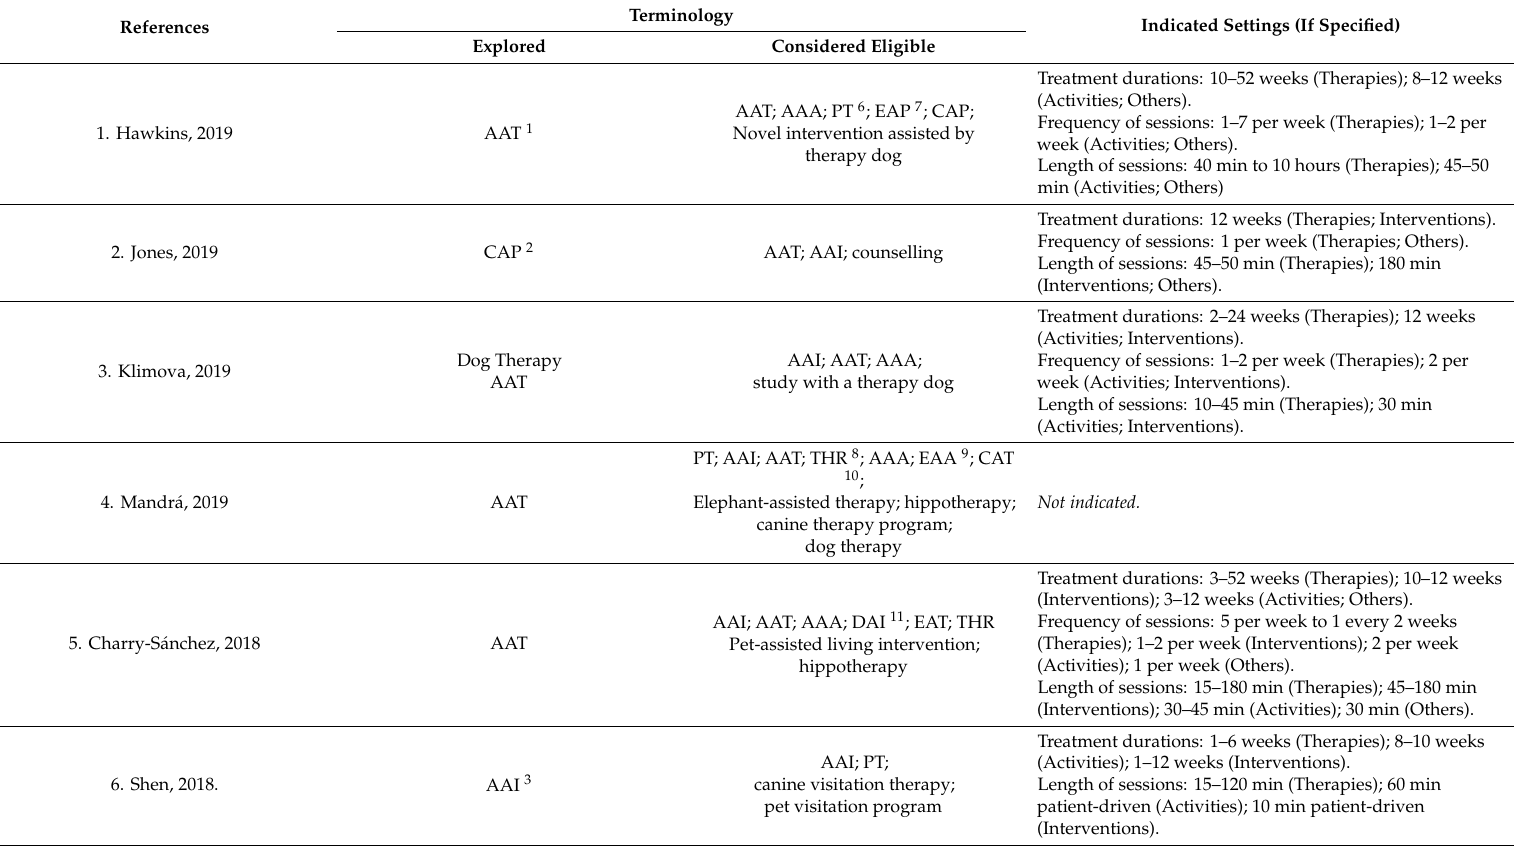
Table 3. Indicated terminologies and